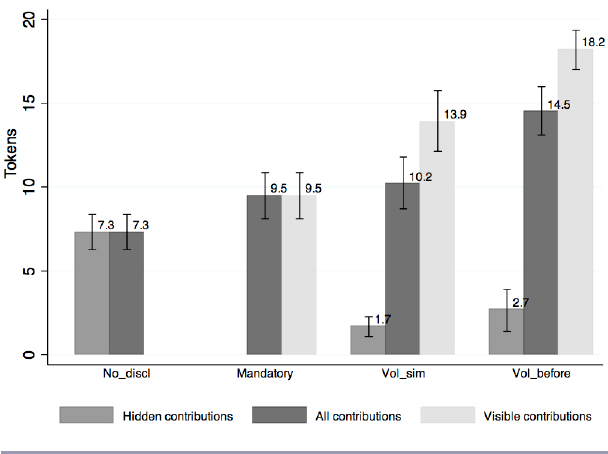
Fig. 2 . Average private, combined, and public individual contributions across treatments.